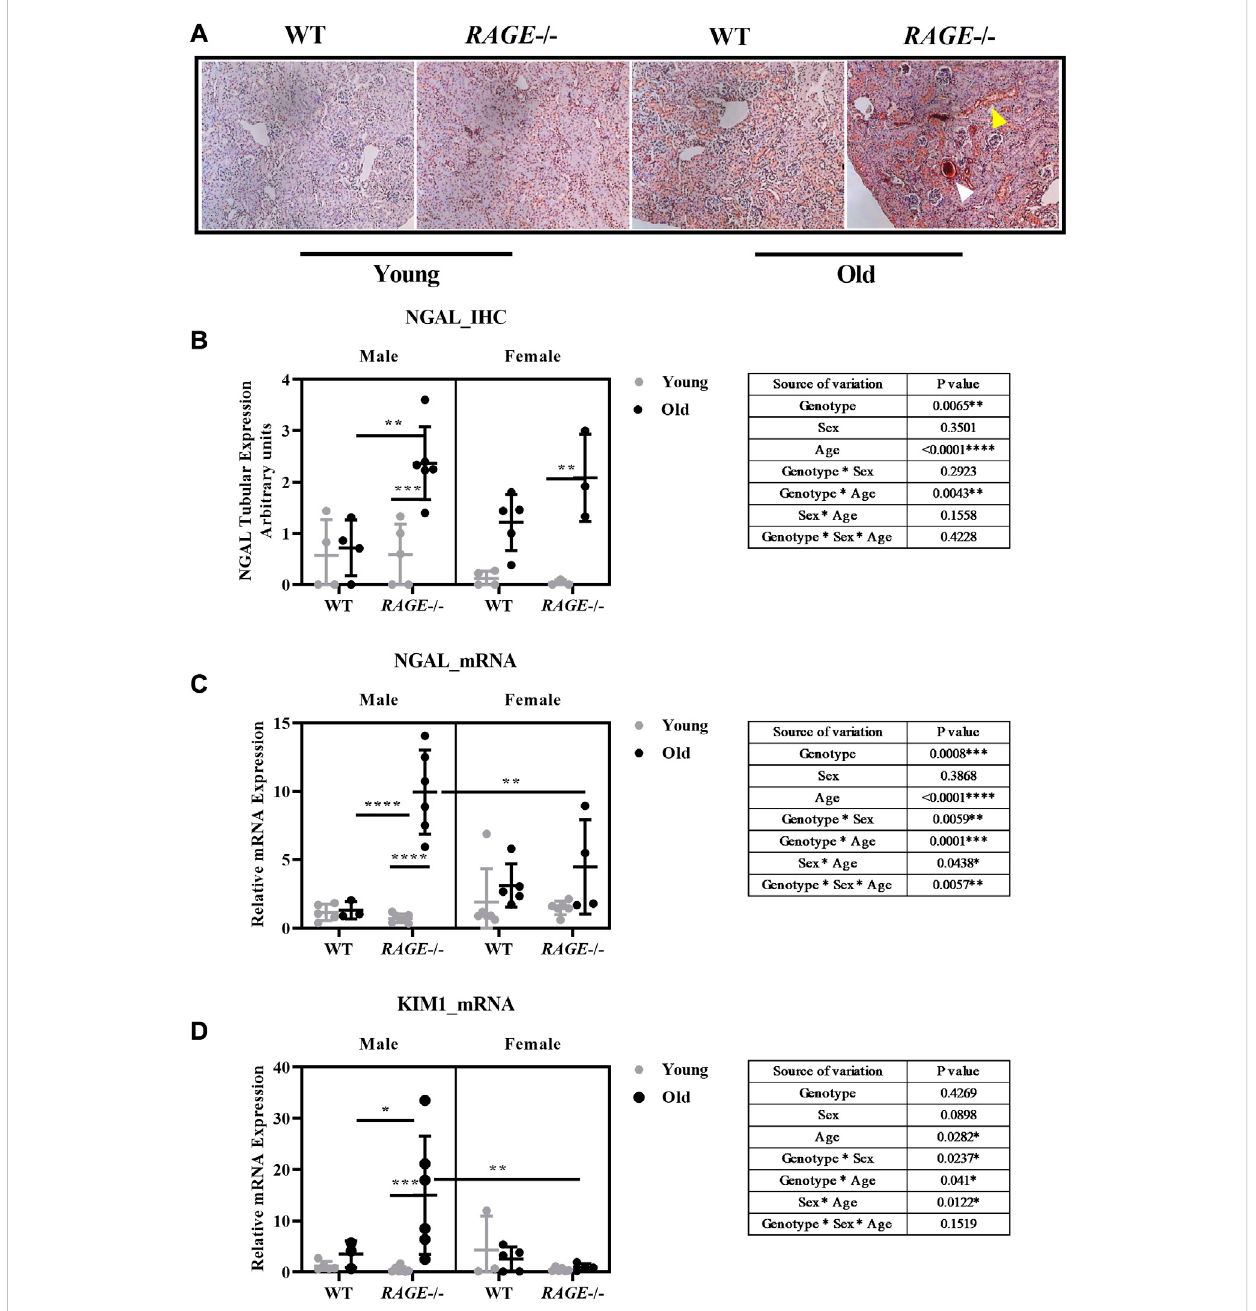
FIGURE 8 Renal damage marker expression at the RNA and protein level: (A) representative images of NGAL immunohistochemistry from the indicated genotypes. Yellow arrows indicate reddish brown NGAL tubular staining, and white arrows indicate intensely stained protein cast in old KO. (B) Quanti fi cation of NGAL IHC, (C) mRNA expression by q-PCR for NGAL, and (D) KIM1 damage markers. Signi fi cance and interaction were calculated by three-way ANOVA with genotype (wild type vs. RAGE − / − , sex (male vs. female), and age (young vs. old) as three factors (shown in table insert). Sidak multiple comparisons tests were performed for intergroup signi fi cance (shown above bars). Young ( < 30 weeks) and old ( > 70 weeks) male and female mice ( n = 3 – 7) were used in the experiment. Images were taken under ×200 magni fi cation. Data are shown as mean ± SD; p- value : 0.05*, 0.01**, 0.001***, and